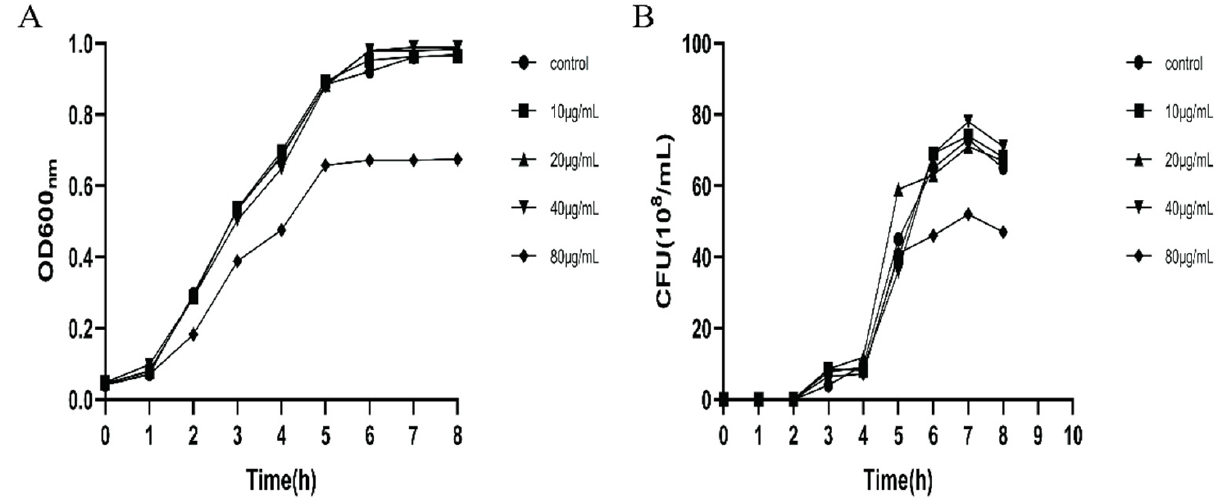
Figure 3. Effects of dictamnine on the in vitro growth of UPEC307. ( A ) Absorbance of bacteria at 600 nm at different time points; ( B ) number of viable bacteria at different time points. CFU: colony-forming unit.